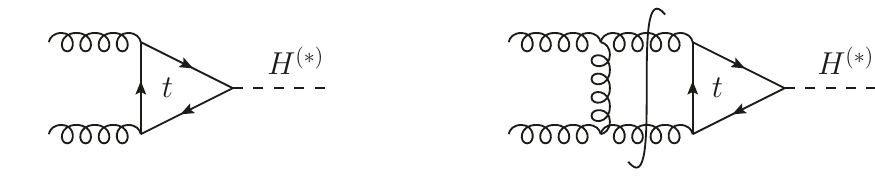
Figure 2 . The LO diagram for Higgs production in gluon fusion (left) and an example for a NLO diagram that contains a branch cut starting at ^ s = 0